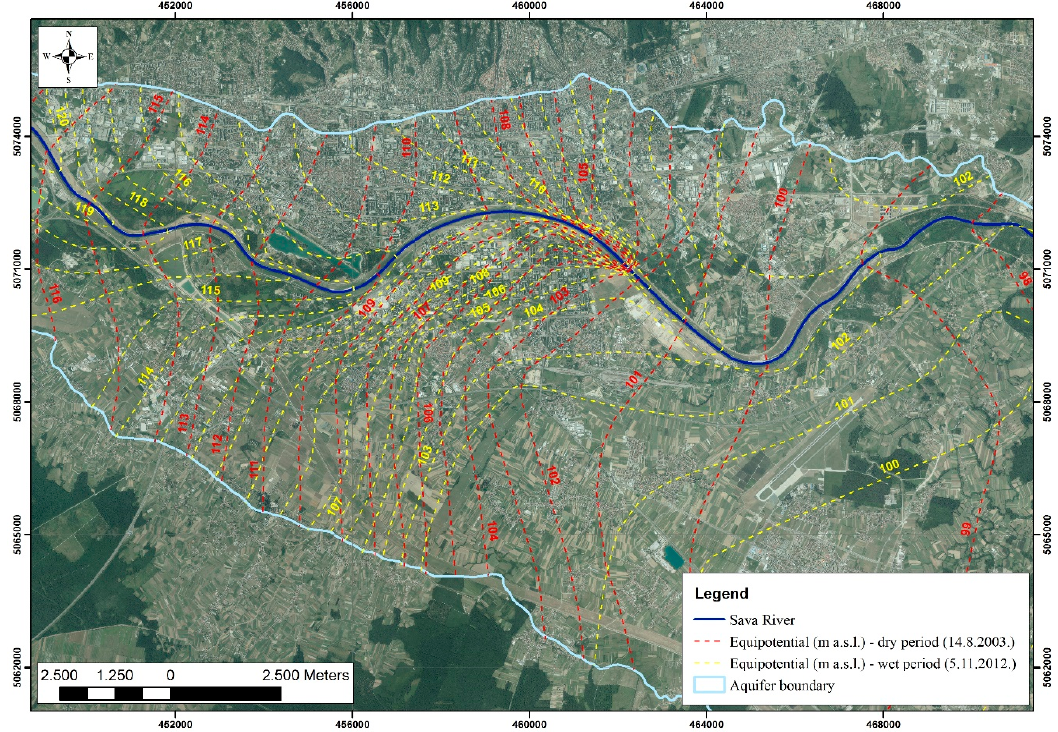
Figure 3. The water table contour map of the Zagreb aquifer during dry and wet periods (equipotentials in meters above sea level (m a.s.l.)) [47].